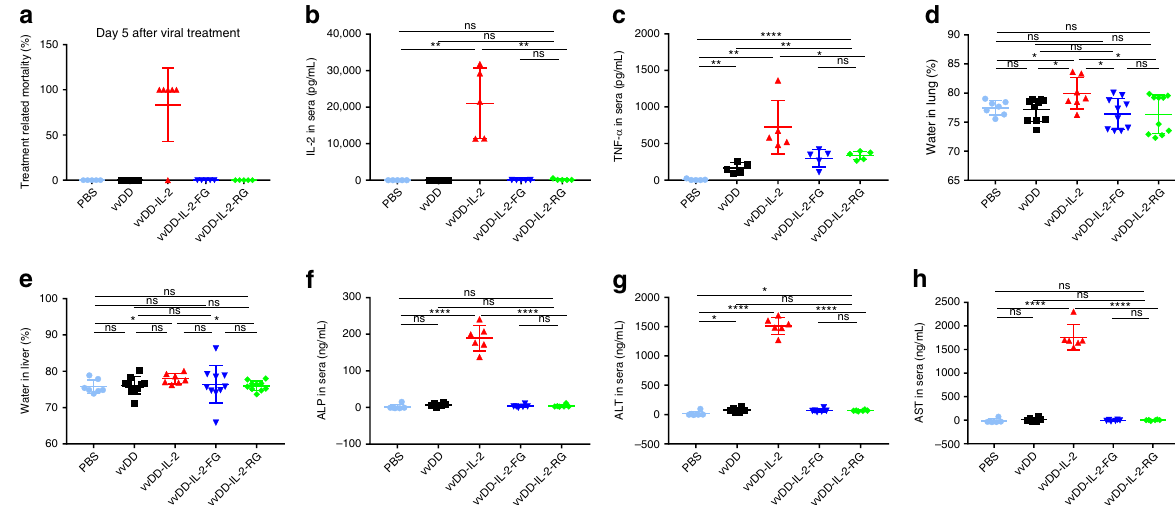
Fig. 2 Toxicity pro fi le of viral-delivered IL-2 variants. B6 mice were i.p. inoculated with 5 × 10 5 MC38-luc cells and treated with PBS, vvDD, vvDD-IL-2, vvDD-IL-2-FG, or vvDD-IL-2-RG at 2 × 10 8 PFU per mouse 9 days post-tumour inoculation. The mice that died earlier than PBS-treated mice, generally within 7 days post-viral treatment, were counted as IL-2-induced death. Five mice were used for each treatment group except vvDD-IL-2 treatment group ( n = 6) and data are representative of two independent experiments ( a ). The treated mice were sacri fi ced 4 to 5 days post-treatment for blood collection to measure IL-2 ( b ) and TNF- α ( c ) in sera and to monitor pulmonary oedema ( d ) and hepatic oedema ( e ). Liver toxicity was assessed by measuring ALP, ALT, and AST in sera by ELISA ( f – h ). Five mice were used for each treatment group and data are representative of two independent experiments ( b , c ); data are combined from two independent experiments ( d , e ) and seven mice were used for PBS or vvDD-IL-2 treatment, and ten mice for other treatments, respectively. Six mice were used for each treatment group and data are representative of two independent experiments ( f – h ); * P <0.05; ** P <0.01; *** P <0.001; and **** P <0.0001. ns: not signi fi